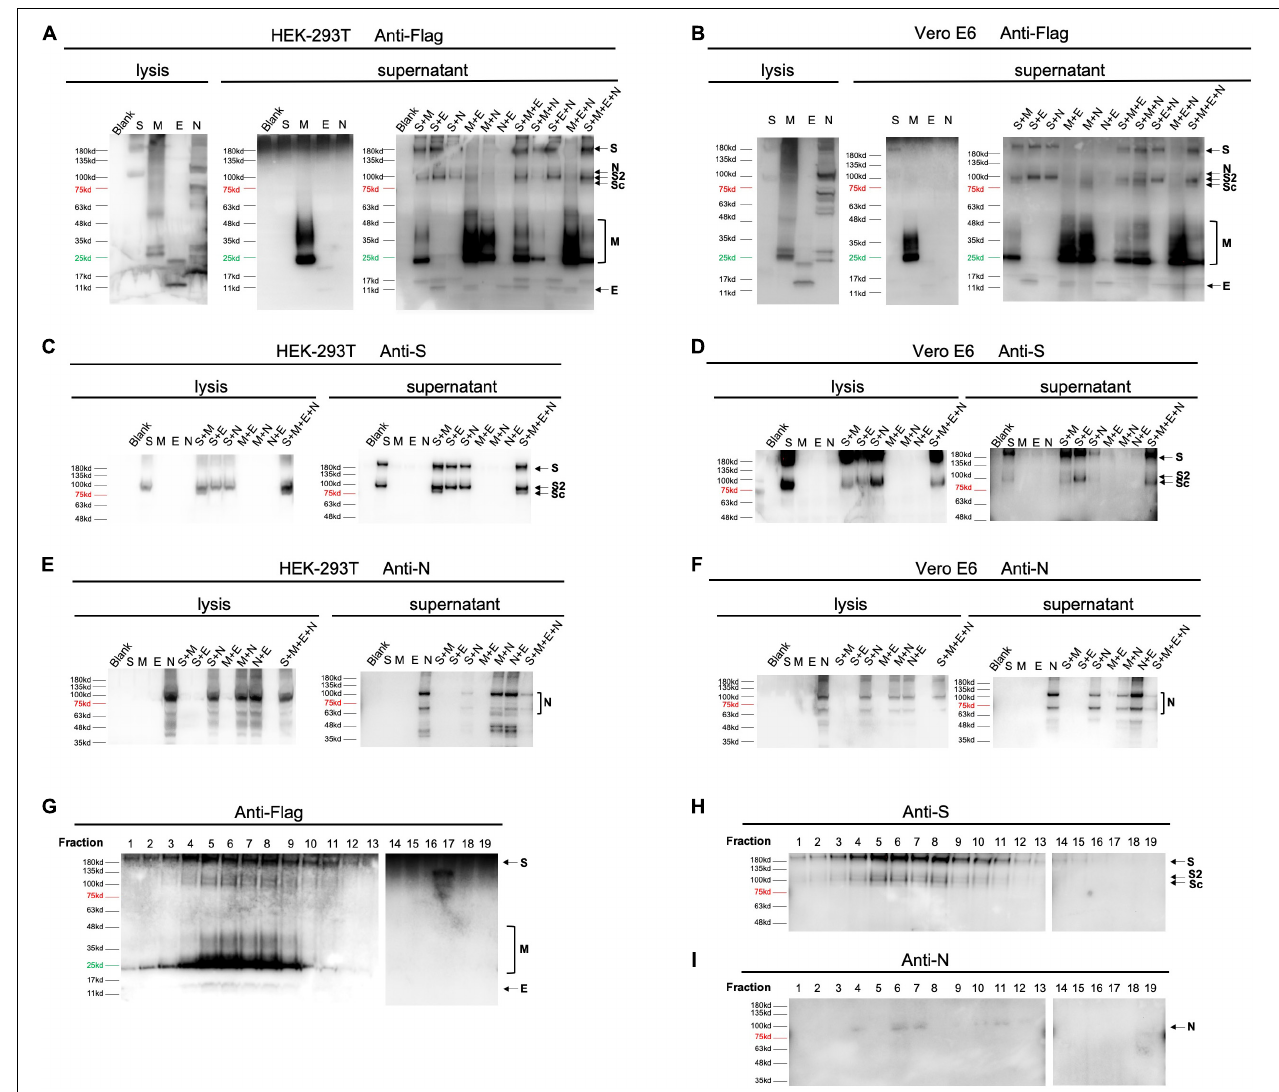
FIGURE 2 | Expression of SARS-CoV-2 VLPs in mammalian expression system. Expression of four structural proteins analyzed using collected cell culture supernatant and cell lysate 48 h after transfection or co-transfection of plasmids encoding S, M, E, or N in both HEK-293T (A,C,E) and Vero E6 cells (B,D,F) . In single plasmid transfection, a total of 2.5 µ g of each plasmid was applied to HEK-293T or Vero E6 cells individually. For double and triple plasmids co-transfection, S, M, E, or N plasmid was introduced at equal molar ratio. Construction of SARS-CoV-2 VLPs was performed by co-transfecting cells with S, M, E, and N with molar ratio at 8:6:8:3. The overall expression profile of four structural proteins was visualized using anti-flag antibody (A,B) . Anti-S (C,D) and anti-N antibodies (E,F) were additionally used to confirm expression of S and N, which could not be clearly distinguished by anti-Flag antibody. (G–I) , resuspended pellets from ultracentrifuged cell medium were then loaded on a 20–60% discontinuous sucrose gradient and subjected to fractions by ultracentrifugation. Nineteen fractions were collected (1–19, from lightest to heaviest). The nature of viral proteins associated with each fraction was determined by anti-Flag (G) , anti-S (H) and anti-N (I) antibodies. S, full-length spike protein; S2, membrane fusion subunit of spike protein; Sc, a cleaved membrane fusion subunit of spike protein. Protein marker and negative control (Blank) are shown as